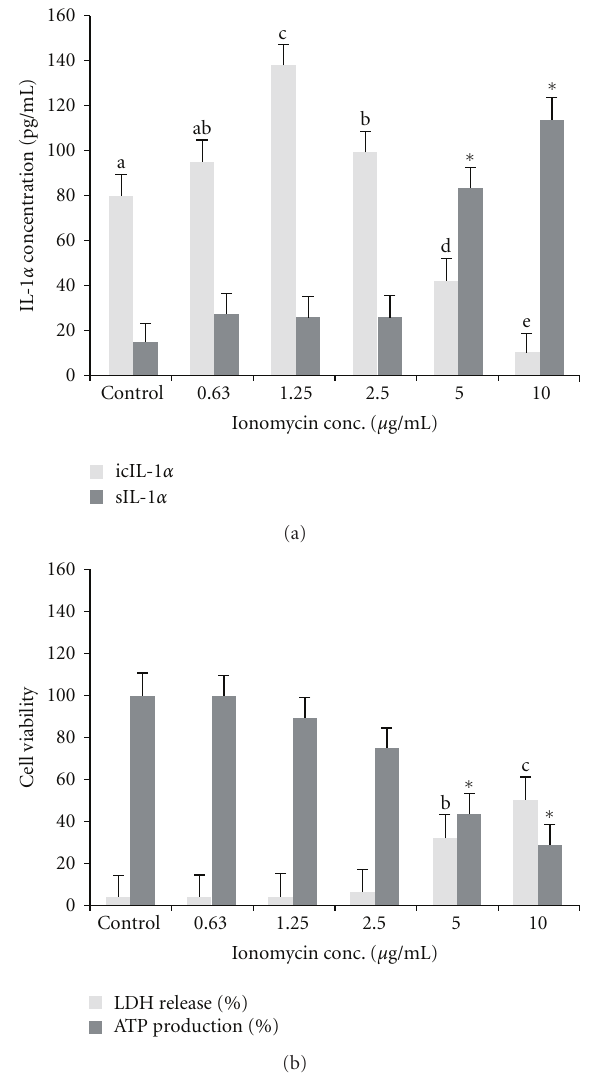
Figure 1: E ff ect of ionomycin on interleukin-1 alpha concentration in the intracellular (icIL-1 α ) and extracellular (exIL-1 α ) environ- ment utilising HaCaT (a). E ff ect on cytotoxicity and cell viability monitored by the % LDH release and the % ATP production, respectively (b). Di ff erent letters or ( ∗ ) on the bars indicates significant di ff erence ( P < 0 . 05) from the control. Values are the means ± SD ( n =